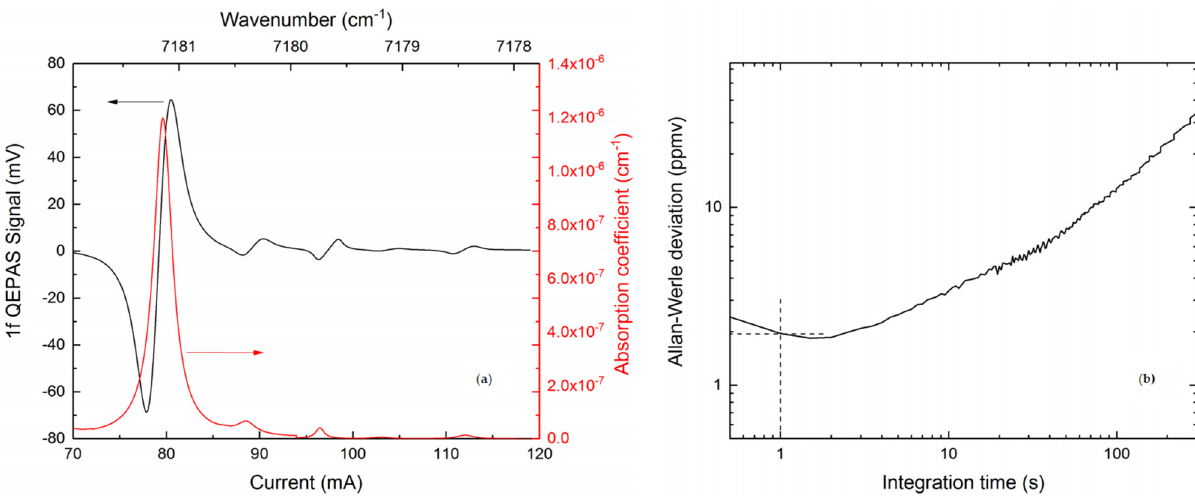
Figure 8. ( a ) 1f optimized double mR QEPAS signal (black). In red, the HITRAN database [18] absorption coefficient of the gas line (1ppmv) is reported. ( b ) Allan-Werle deviation calculated from a 15 nm acquisition of the 1f QEPAS signal.